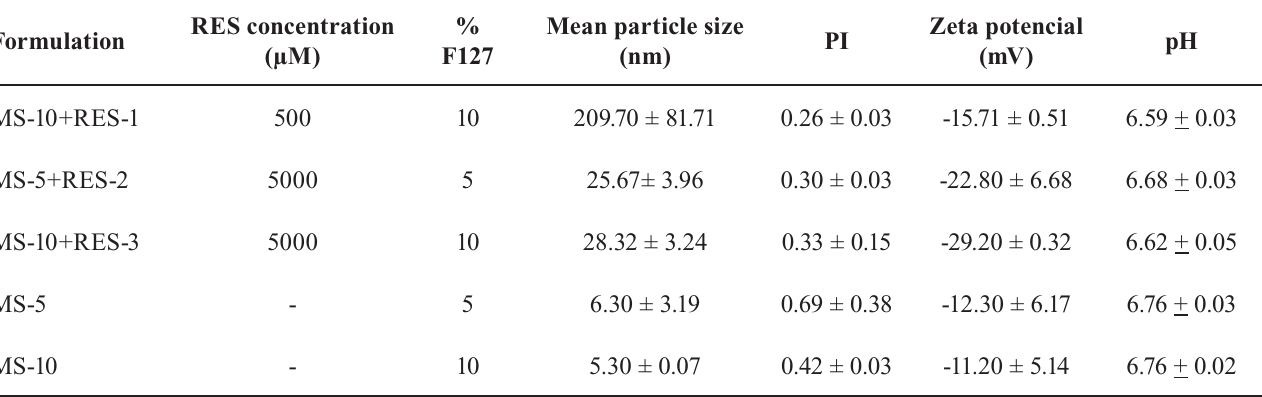
TABLE I - Composition of micellar formulations, mean particle size, polydispersion index (PI), zeta potential and pH (mean + SD)